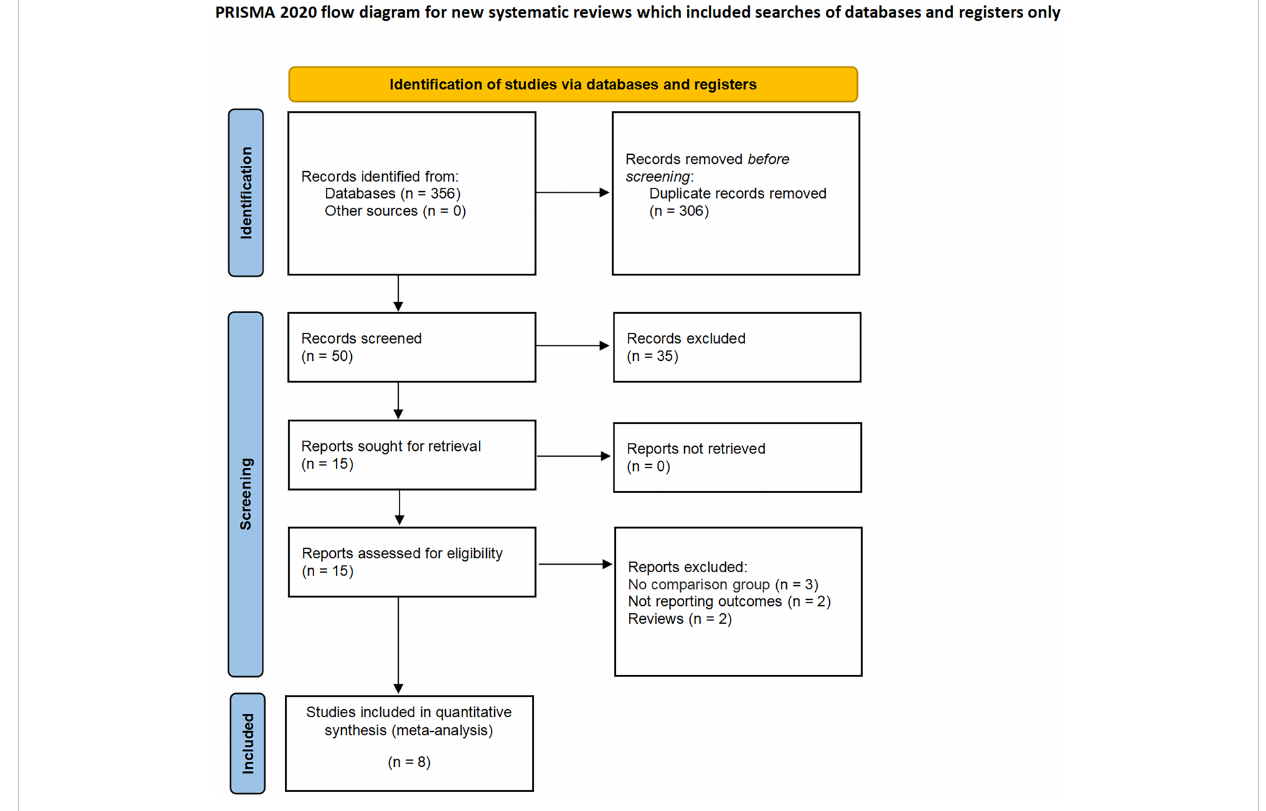
FIGURE 1 PRISMA fl ow diagram for the systematic